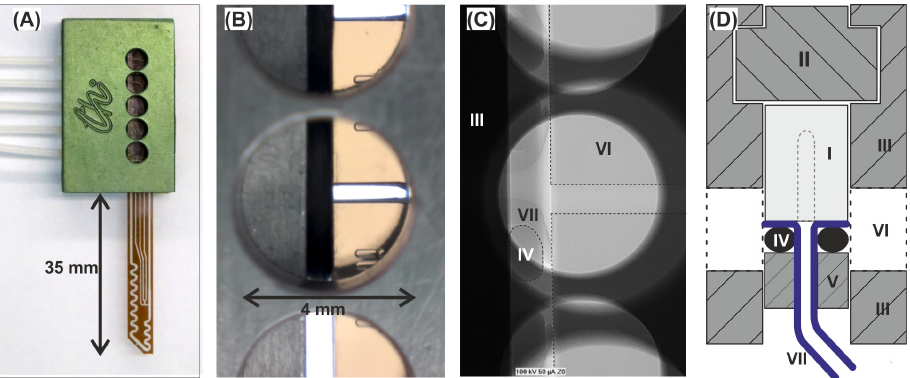
Figure 5. Connector for the DMPTs: ( A ) Image of a DMPT assembled within the connecting frame equipped with five tubes (Q 1–5 ). The aluminum main frame contains five inspection openings which allow the alignment of the DMPT relative to the flanged tubing. ( B ) Magnification of an inspection opening showing the glass device with channel and O-ring gasket bearing the flanged tubing. ( C ) X-ray image of the in ( B ) shown assembly; ( D ) Cross-sectional scheme perpendicular to the top view showing following elements: I: DMPT; II: polymeric support for the fluidic device; III: main frame with inspection openings; IV: O-rings; V: crossbar with through holes for the tubing; VI: inspection openings for aligning adjustment; VII: flanged tubing.